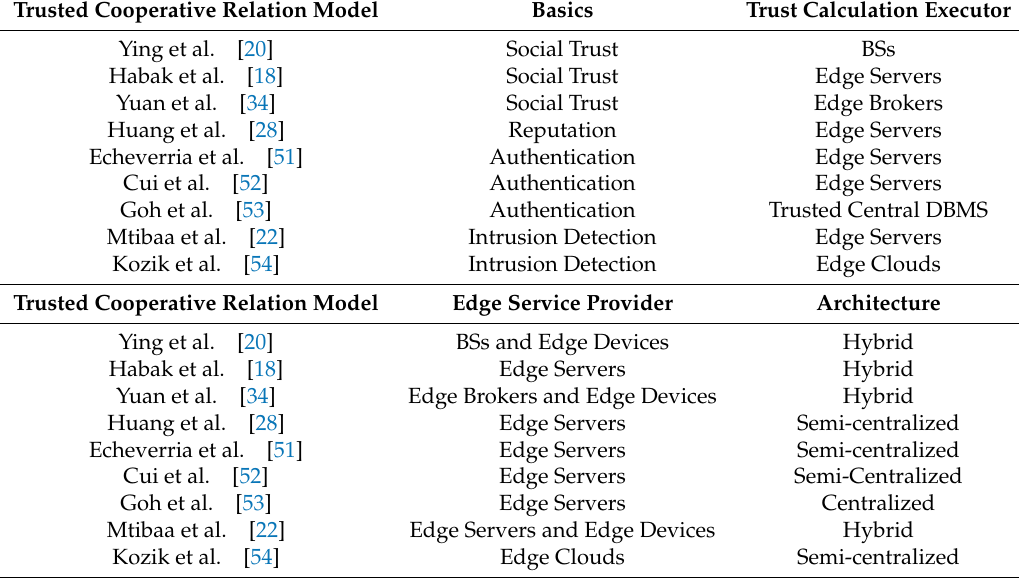
Table 2. Comparison of trusted cooperative relation models for MEC